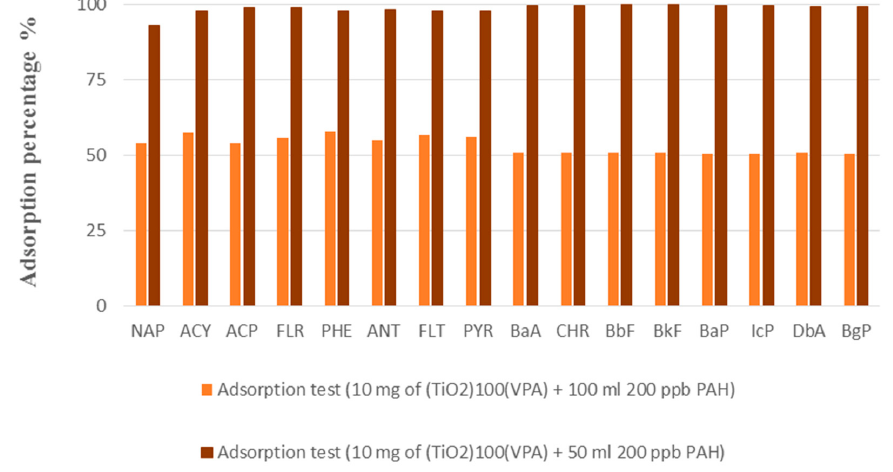
Figure 6. Batch adsorption tests of (TiO 2 ) 100 (VPA) after 24 h.